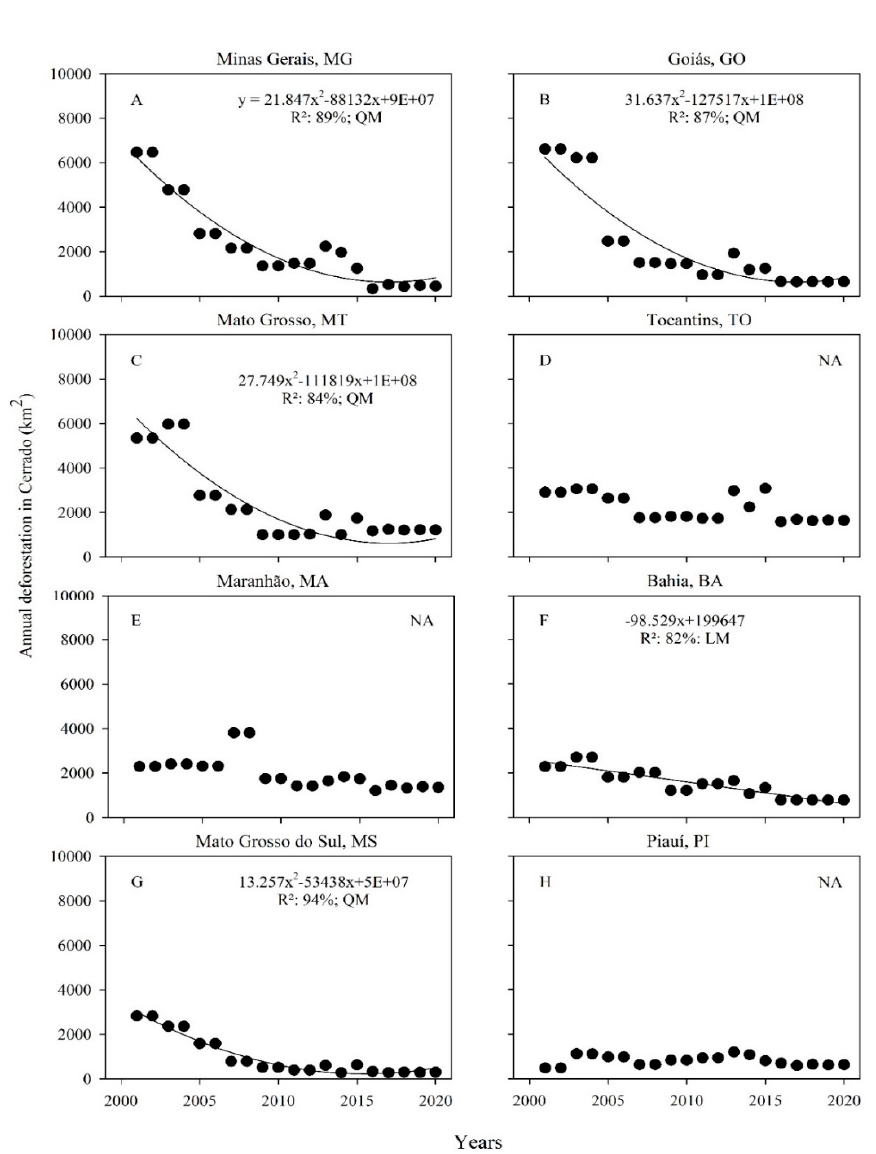
Figure 4. Annual deforestation (km 2 ) in Minas Gerais, Goiás, Mato Grosso, Tocantins, Maranhão, Bahia, Mato Grosso do Sul, and Piauí from 2000 to 2020. QM and NA represent quadratic and non-adjusted models, respectively.